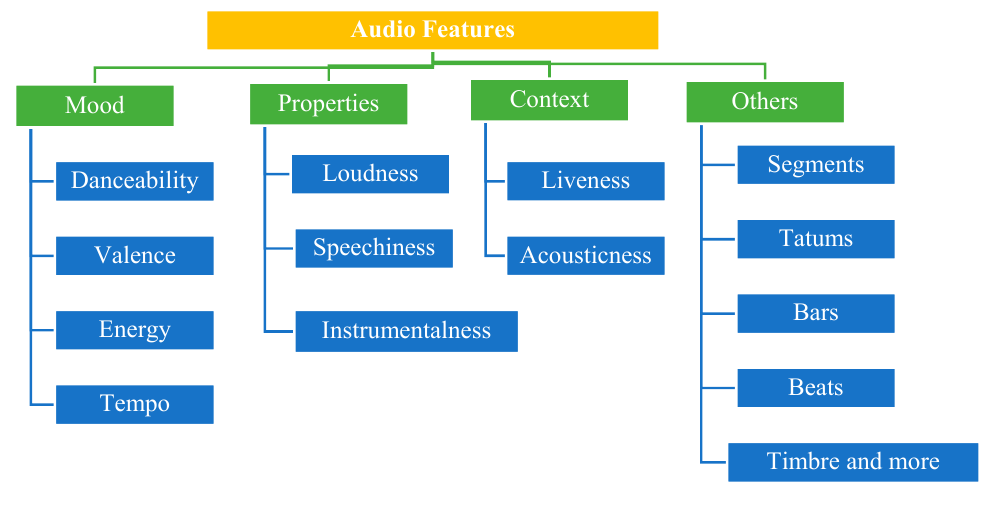
Figure 1. Audio features .